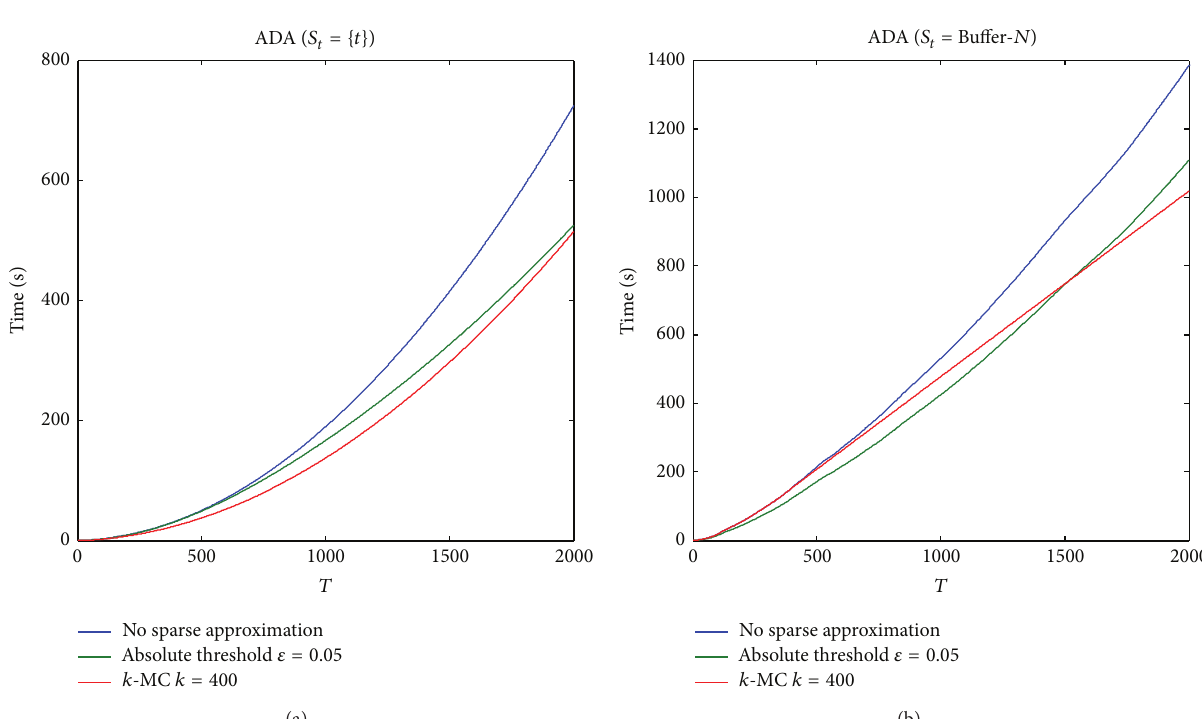
Figure 4: Cumulative runtime growth curves. From left to right (a) ADA ( 𝑆 𝑡 = {𝑡} ); (b) ADA (Buffer- 𝑁 ). The curves have the similar trends for different online coregularization algorithms. Online coregularization algorithms with sparse representation perform better than the basic online coregularization algorithms on the growth